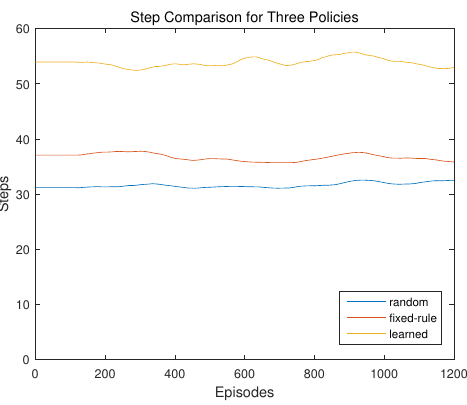
Figure 10. The steps of three policies.